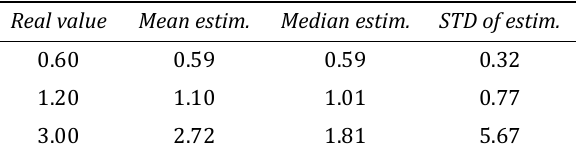
Table 4. Real and estimated gaze distances (mean, me- dian, and STD), in meters, using all the data. Real value Mean estim. Median estim. STD of